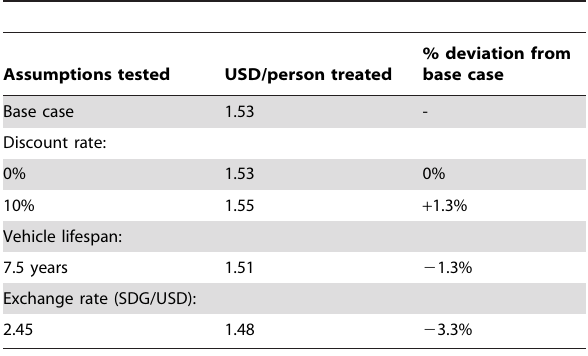
Table 3. Sensitivity of economic cost estimate to underlying